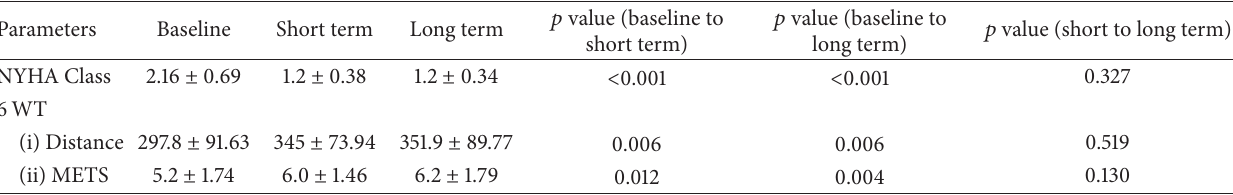
Table 3: Functional capacity parameters.